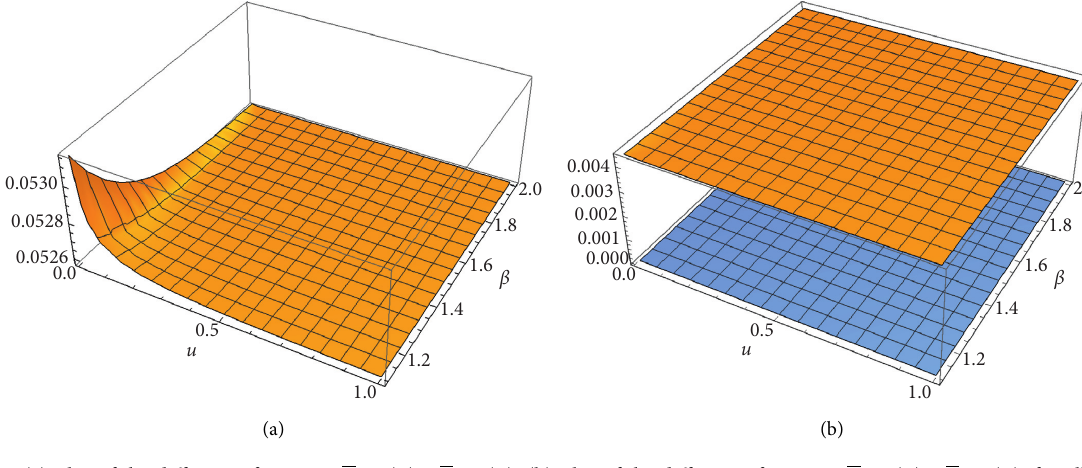
( x ) − F ( x ) , for all x � − ln u Y ∗ Y ∗∗ 2 : 2 2 : 2